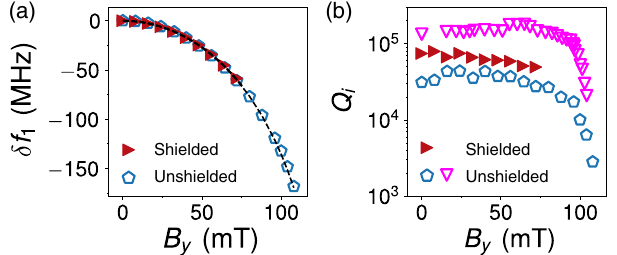
FIG. 5. Magnetic field dependence. (a) Relative change in qubit − f frequency δ f 1 ¼ f 1 ð B 1 as a function of the applied in- y Þ plane magnetic field B (see Appendix F for field alignment). The y experimental data were measured in two separate cooldowns: with (filled triangles) and without (open pentagons) an outer superconducting Al shield (see Appendix A). The field depend- ence can be fitted to a two-fluid model [44] (see Appendix G), indicated by the black dashed line, from which we extract the thin 150 (cid:2) 5 mT, in film Al critical flux density B c; Al ¼